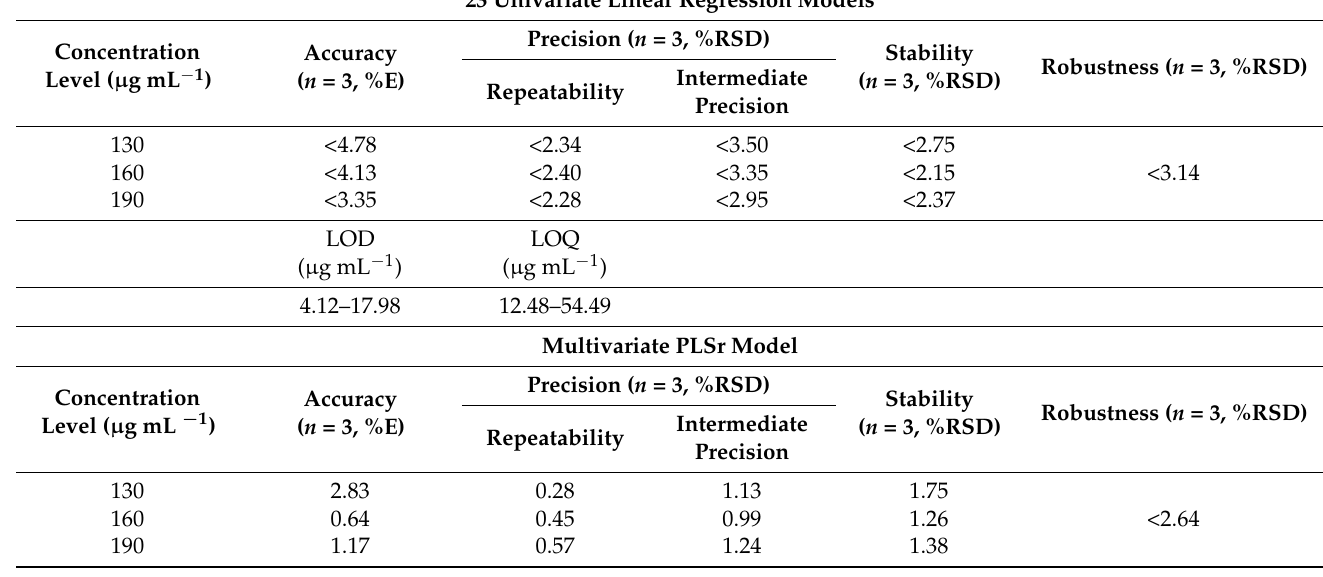
Table 4. Accuracy, repeatability, intermediate precision, stability and robustness assessed for the 23 univariate linear regression models and the Partial Least Square regression (PLSr) model developed for the assay of CMS in pharmaceutical formulations using the proposed UPLC–TUV methodology. The limit of detection (LOD) and limit of quantitation (LOQ) values were calculated only for the univariate